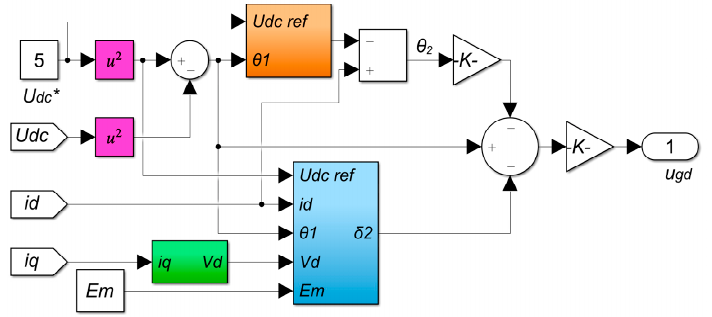
Figure 3. Simulation model of active component control structure controlled by backstepping con- trol method.